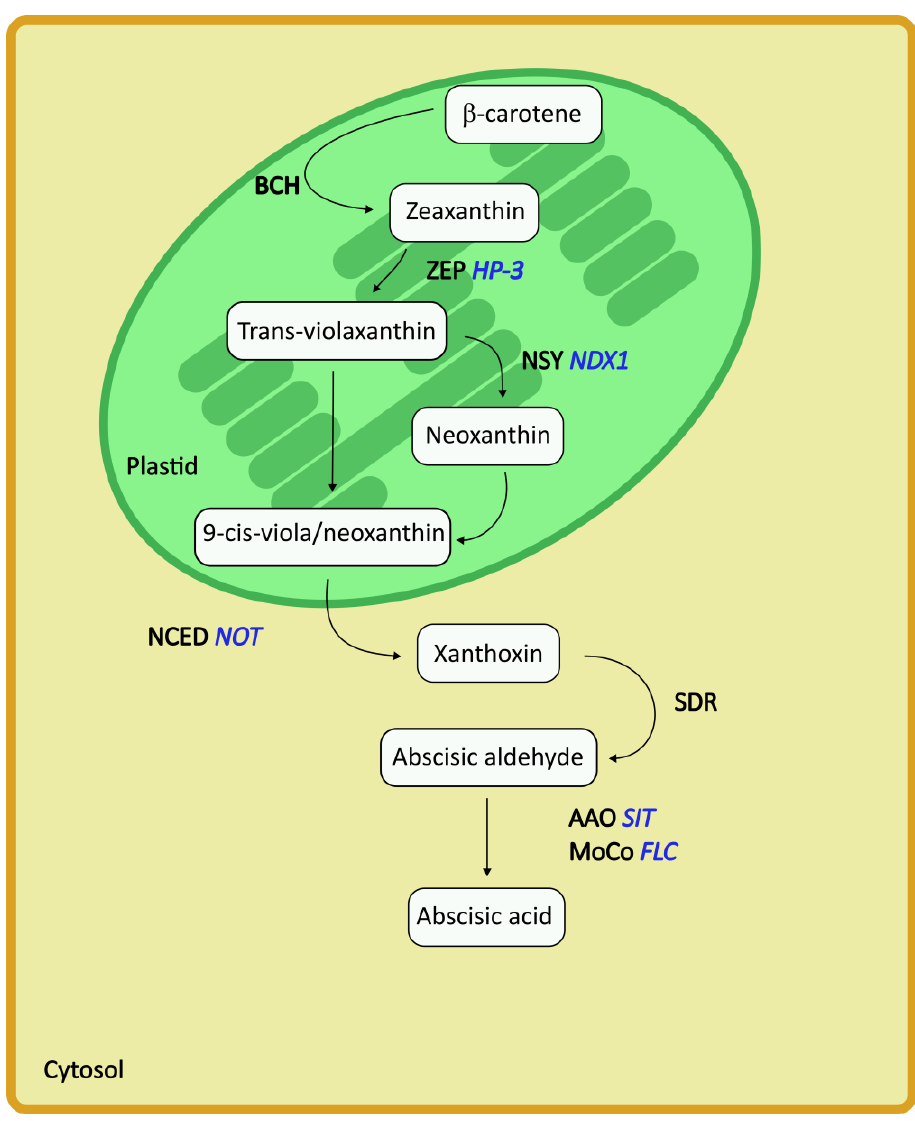
Figure 1. ABA biosynthesis in tomato. In plastids, β -carotene is converted into zeaxanthin through the action of β -carotene hydroxylase (BCH). Zeaxanthine is converted into trans-violaxanthin by ZEP, encoded by hp3 . Trans-violaxanthin is further modified into neoxanthin by NSY — encoded by NDX1 — or into cis-violaxanthin by an enzyme still uncharacterized in tomato. Both intermediates are substrates for NCED — encoded by NOT — to be converted into xanthonin. Xanthonin moves across the plastid membrane to the cytosol for conversion into abscisic aldehyde first — a reaction catalyzed by SDR — and finally to ABA. This last step is catalyzed by the combined action of AAO and MoCo, respectively, encoded by SIT and FLC .